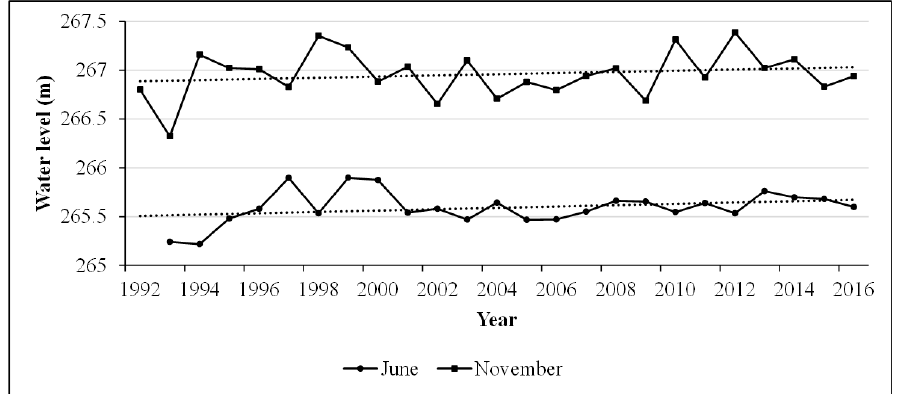
Figure 11. Time series of water levels observed in June and November.